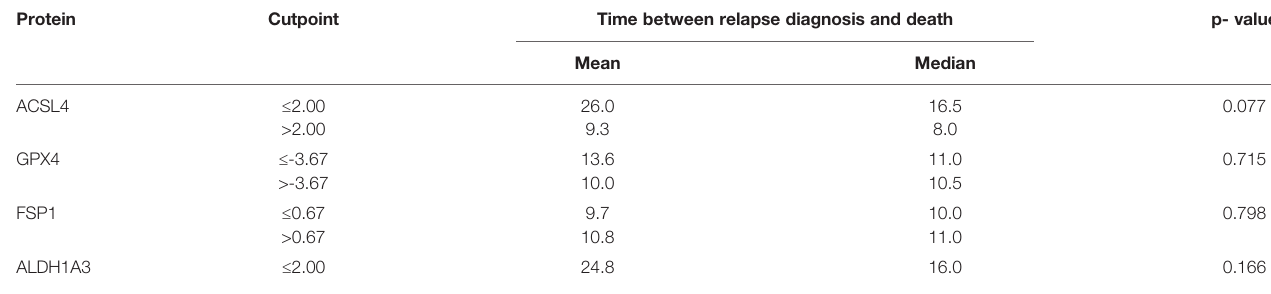
TABLE 6 | Summary of results of survival analysis.